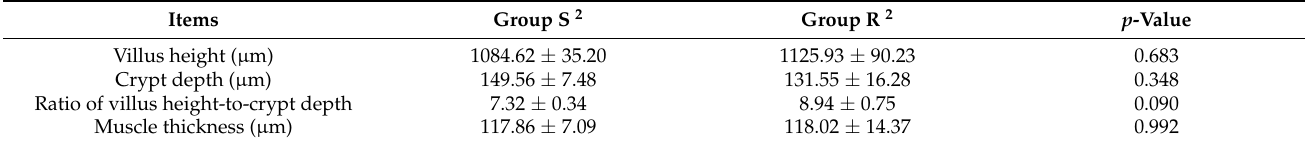
1 Results are expressed as means ± SEM, with n = 8 per group. 2 Group S = selected S. enteritidis -susceptible chicks; Group R = selected S. enteritidis -resistant